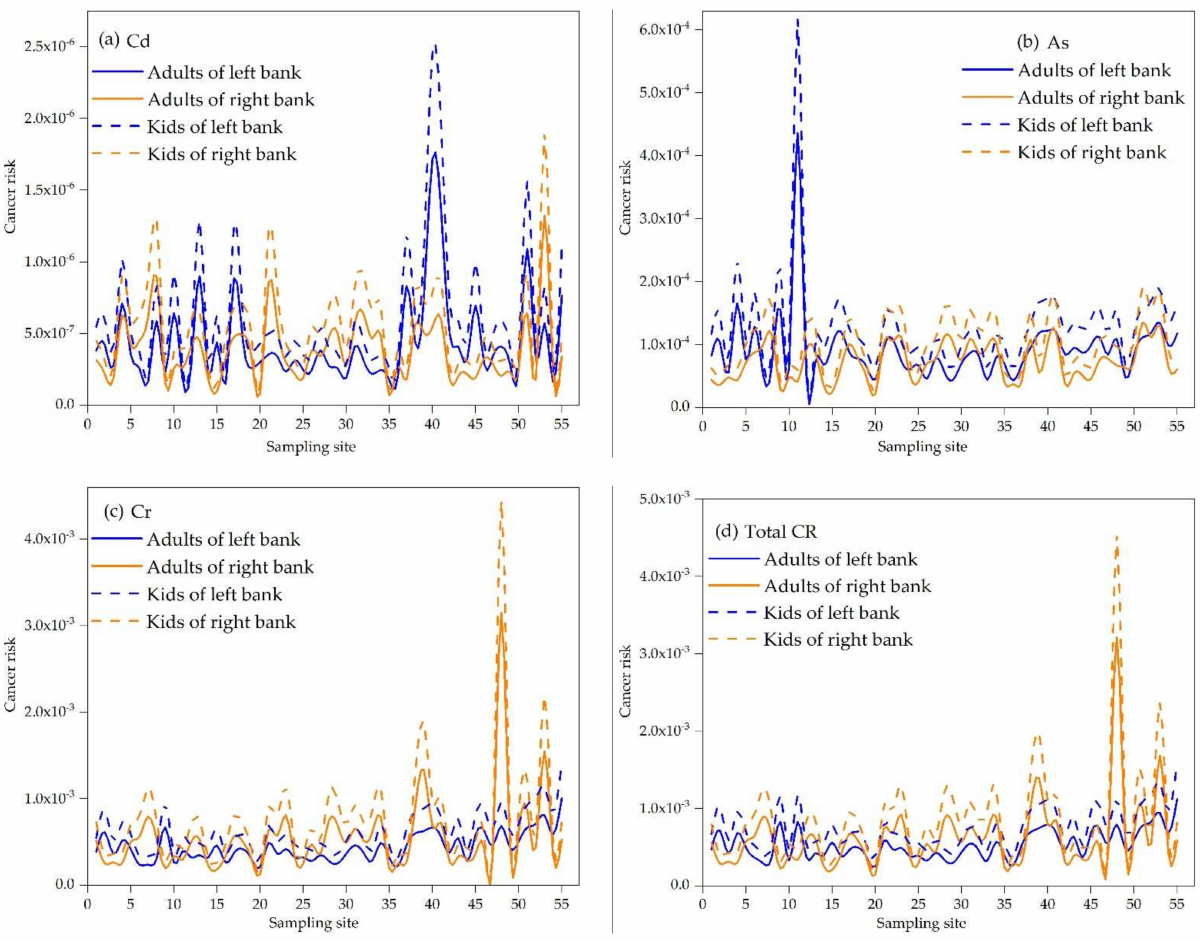
Figure 5. Comparison of carcinogenic risk distributions ( a ) CR value of Cd comparison between adults and kids on the left bank and the right bank; ( b ) CR value of As comparison between adults and kids on the left bank and the right bank; ( c ) CR value of Cr comparison between adults and kids on the left bank and the right bank; ( d ) total CR value comparison between adults and kids on the left bank and the right